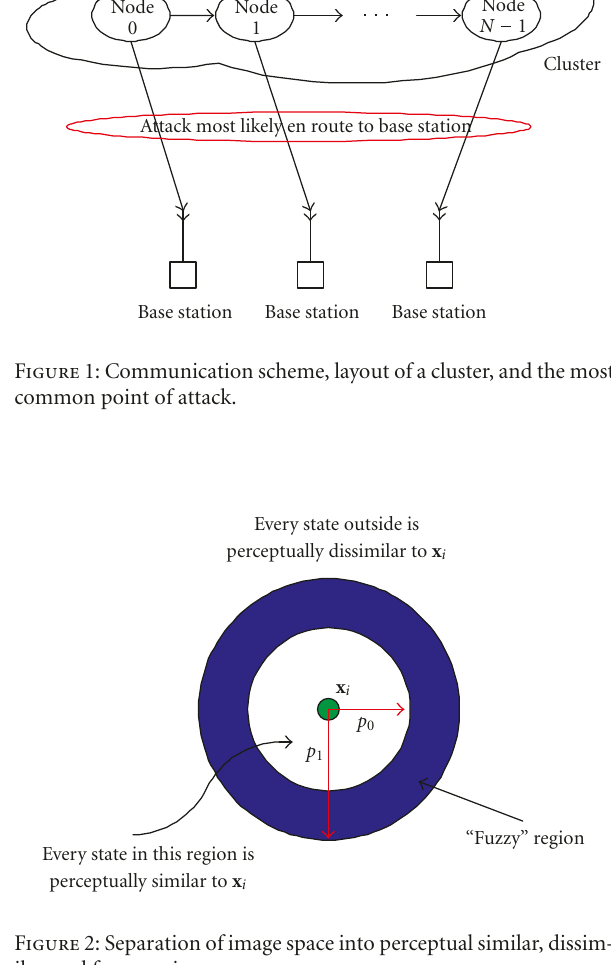
Figure 2: Separation of image space into perceptual similar, dissim- ilar, and fuzzy